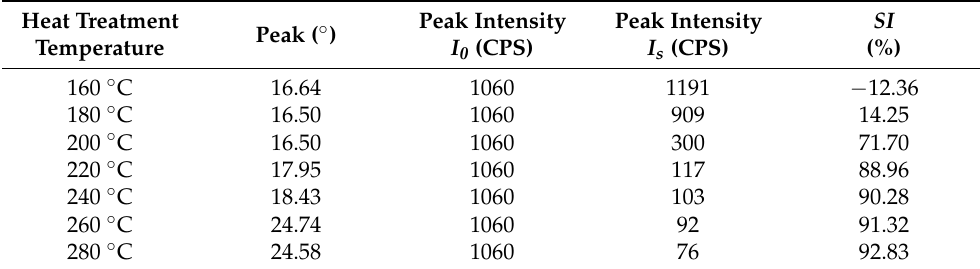
Table 5. SI results of P (AN- co -MLA) copolymers with feed ratio of AN/MLA = 97/3 (wt/wt) at different temperature for 30 min.